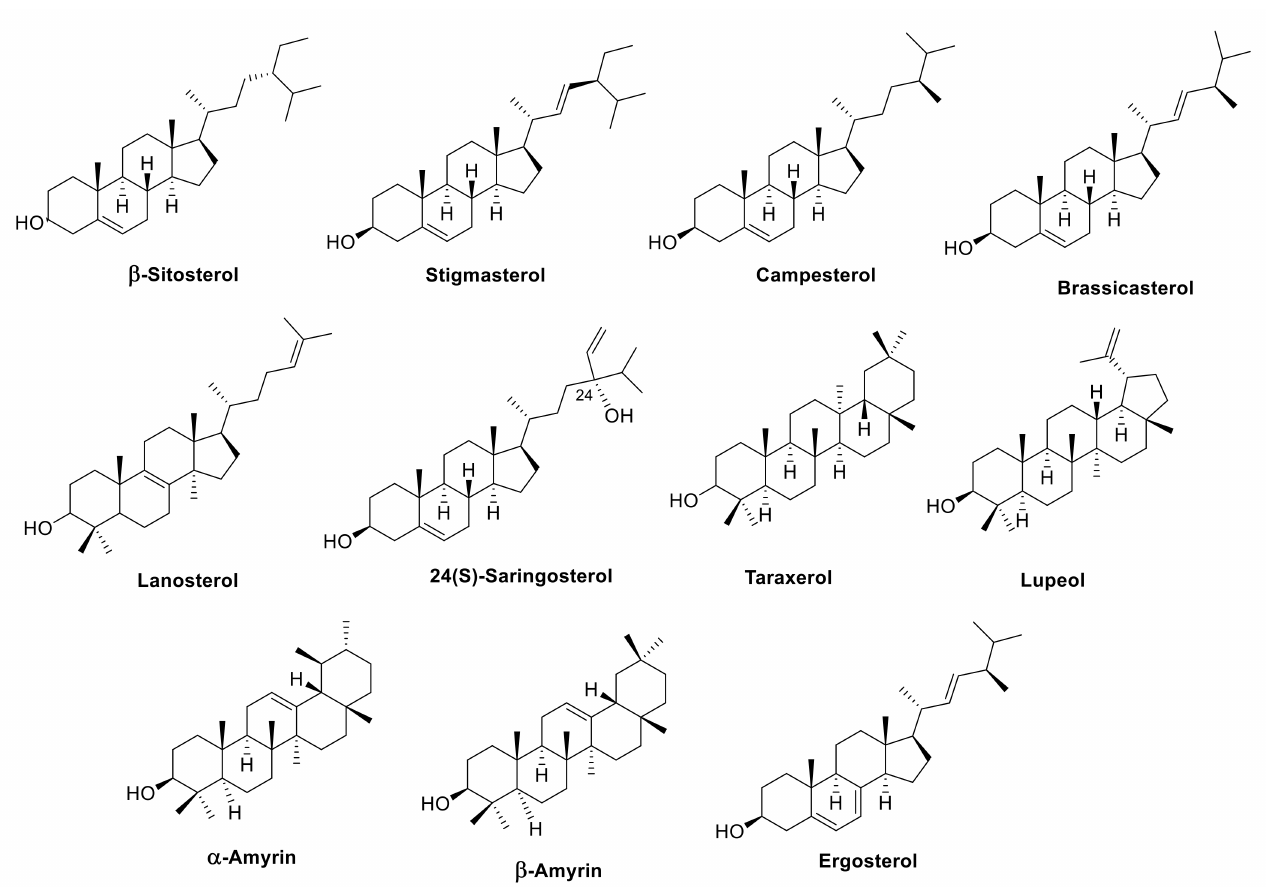
Figure 4. Structure of the phytosterols with potential activities against neurodegenerative